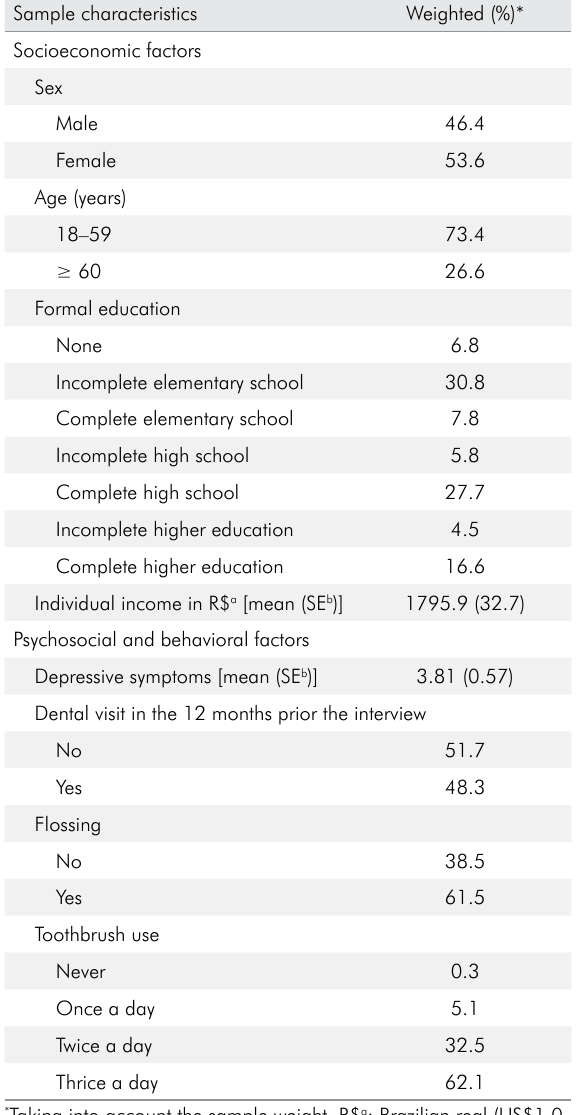
Table 1. Characteristics of the sample from the National Health Survey (PNS) (n =